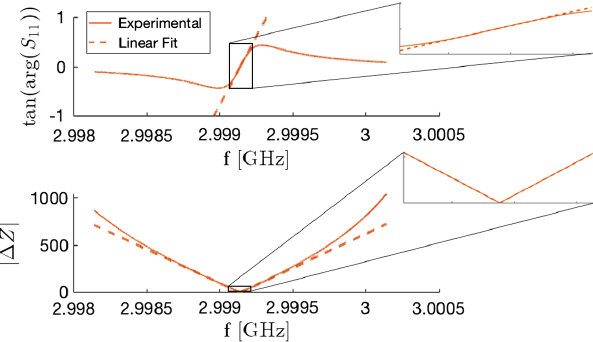
FIG. 13. Measured variation in tan ½ arg ð S 11 Þ(cid:3) (top) and j Δ Z j (bottom) with driving frequency. The insets enlarge the region contained inside the black